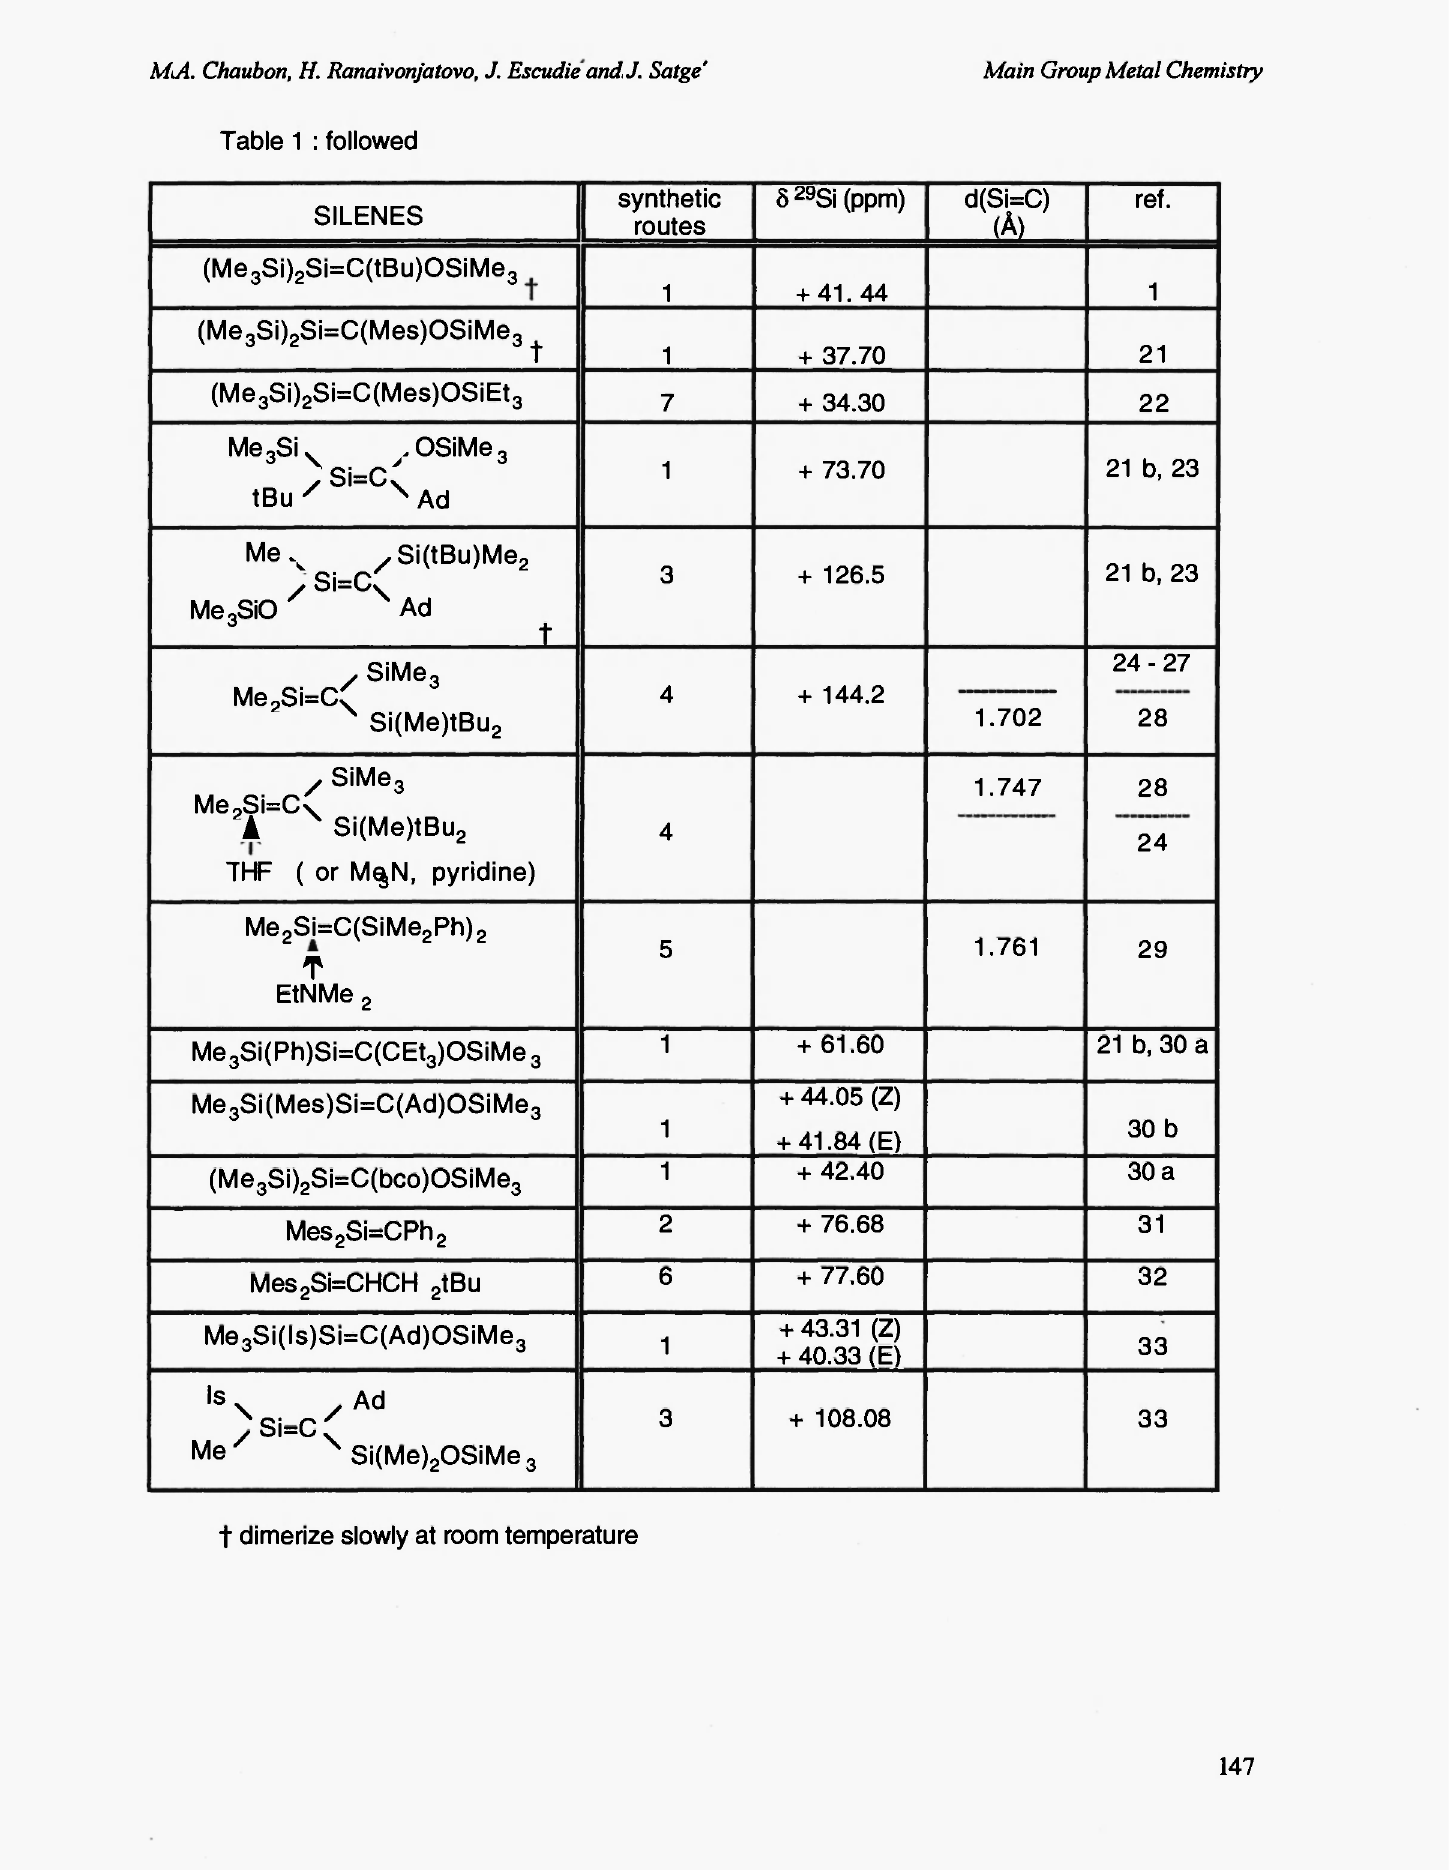
Table 1 : followed SILENES